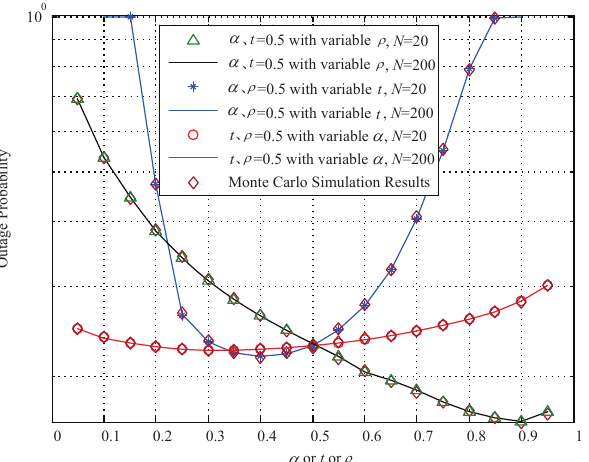
Figure 3. Outage probability vs. PA ratio α , TA ratio t , or PS ratio ρ